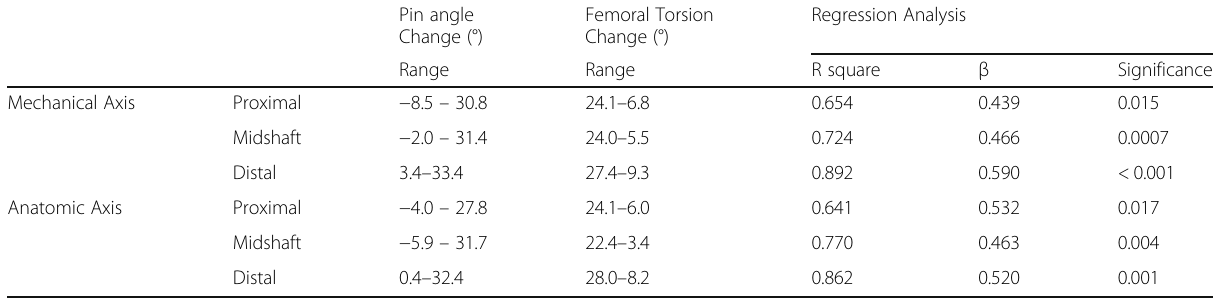
Table 1 Effect of femoral external rotational osteotomy location on femoral torsion correction (negative pin angle change is external rotation)